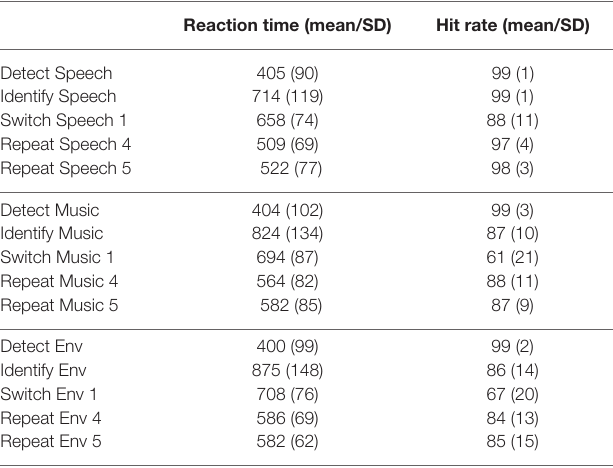
TABLE 3 | Comparison of responses across